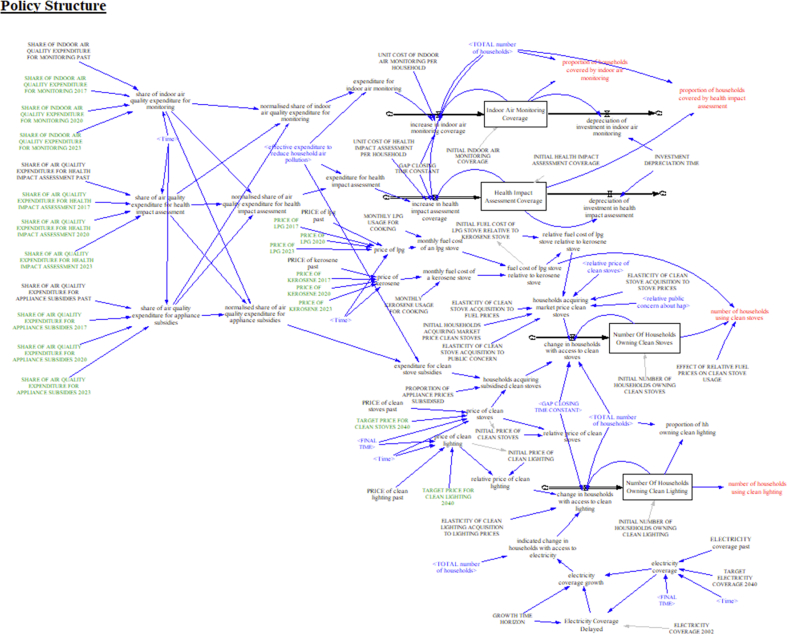
Policy structure.